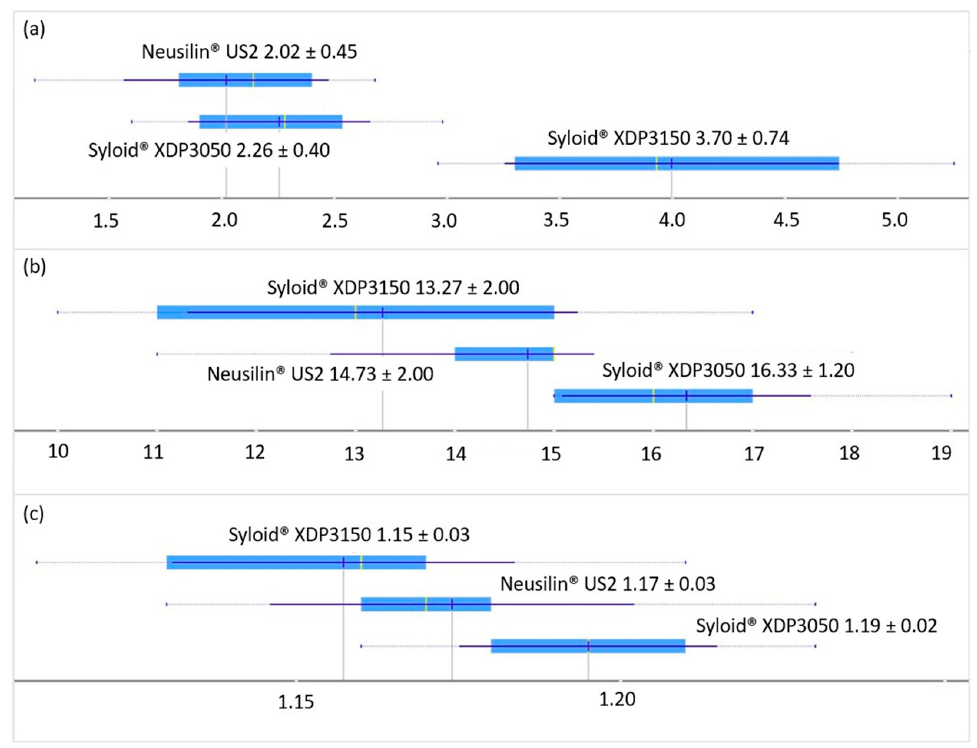
Figure 2. Flow properties of LS admixture presented as the mean value ± standard devation: ( a ) flow rate (g/s); ( b ) Carr index (%); ( c ) Hausner ratio.